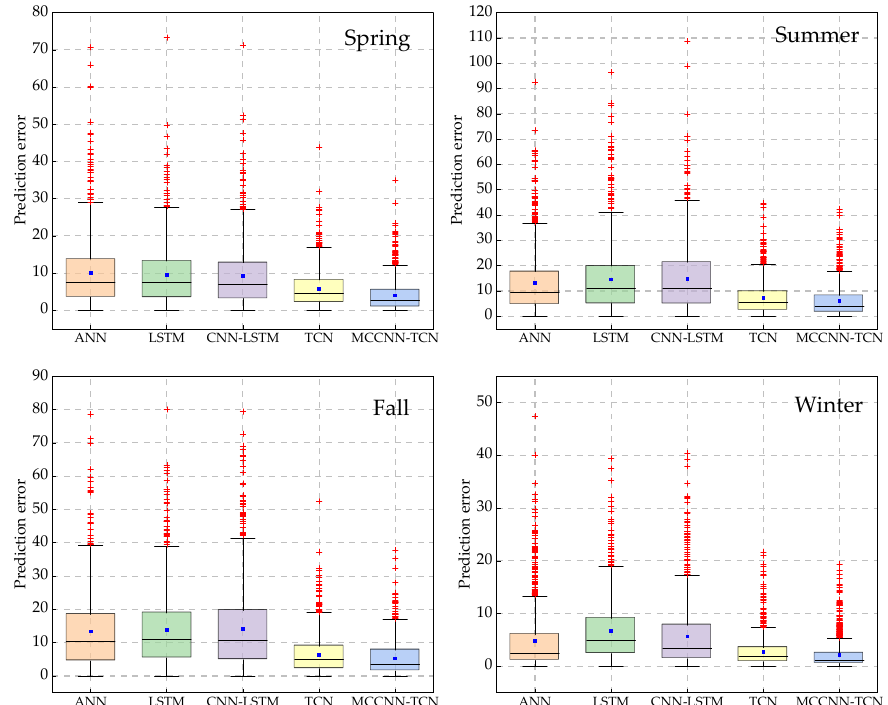
Figure 9. Box plot of absolute prediction errors for different methods in each season.